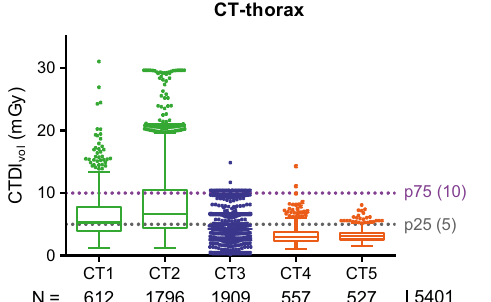
Fig. 4 Detection of differences in the range of dose levels for CT-thorax studies in the participating hospitals. Box plot of the CTDI vol -median value, interquartile range, total range and outliers for all CT-thorax exam- inations on the five CT systems with the national P75 and P25 DRLs